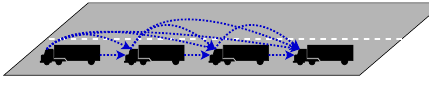
Figure 9. Two-predecessors following the topology of platooning